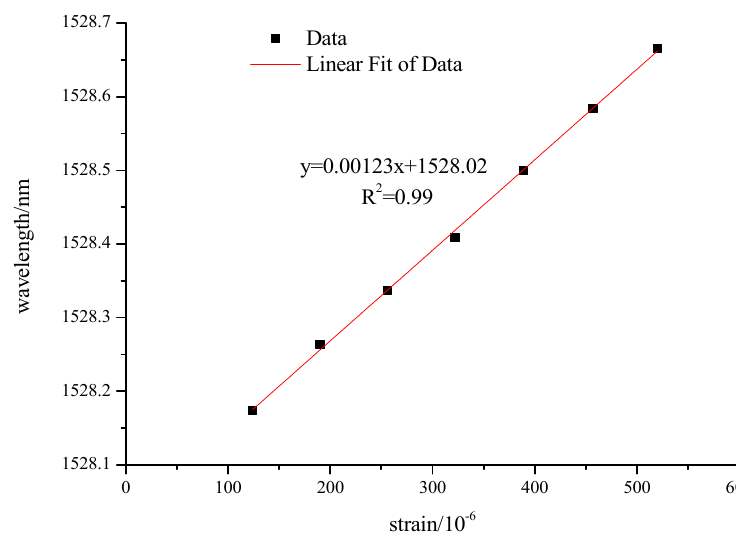
Figure 10. Calibration curve from tests on a bare FBG sensor.